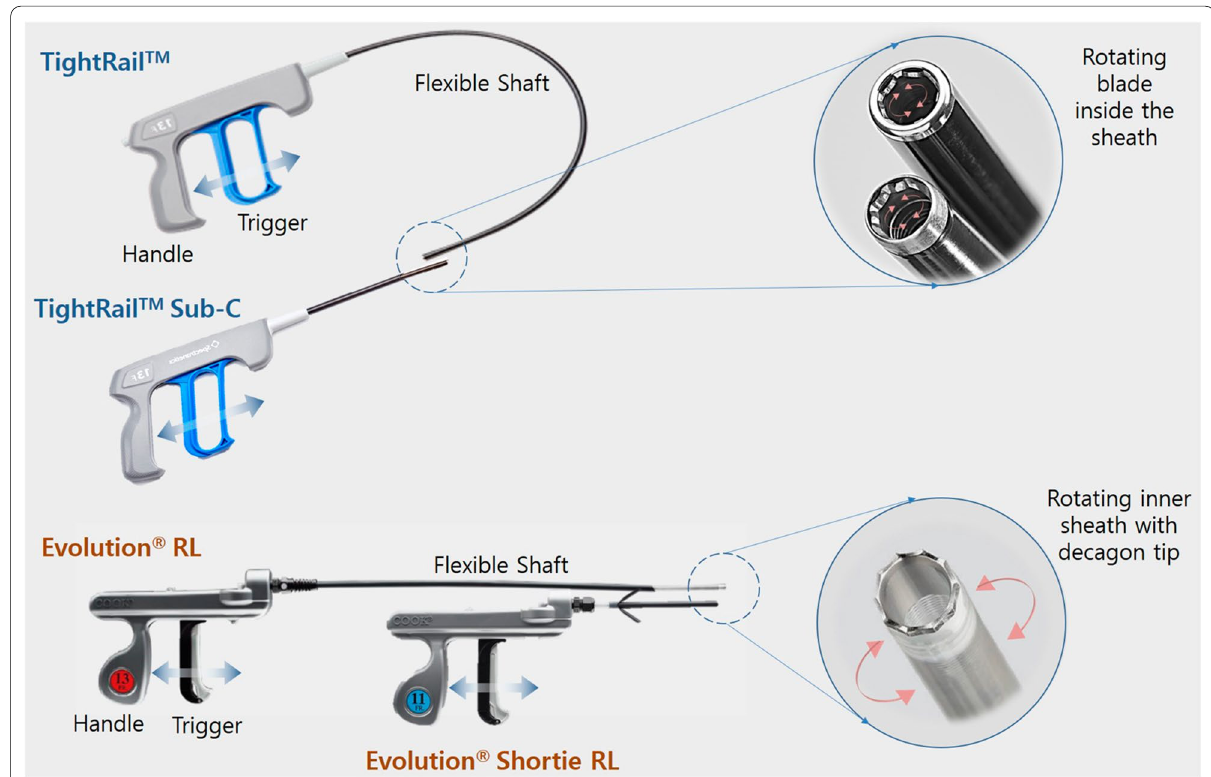
Fig. 1 Rotational mechanical dilator sheaths. TightRail and Evolution systems have standard and short versions of the sheaths. The TightRail has rotating blade inside the sheath while the Evolution RL has rotating inner sheath with decagon cutting